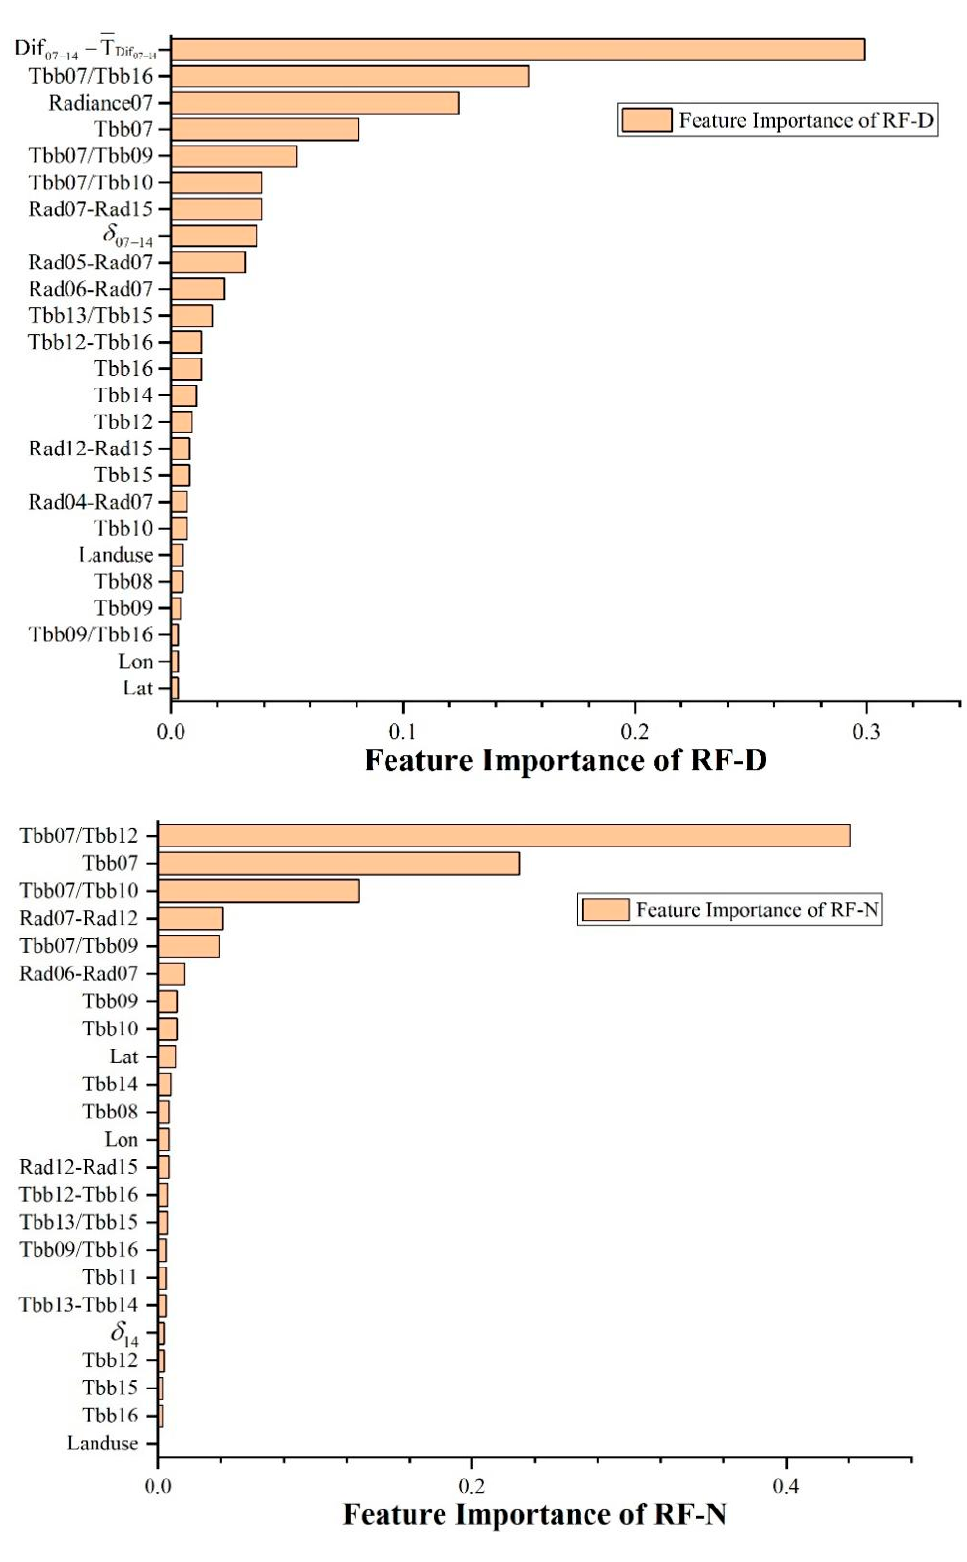
Figure 4. Ranking the features importance of RF-D and RF-N models.